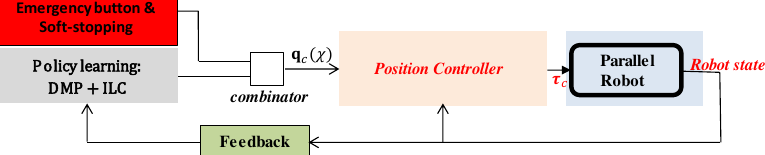
Figure 4. Simple diagram of the control of the proposed force-based trajectory learning and